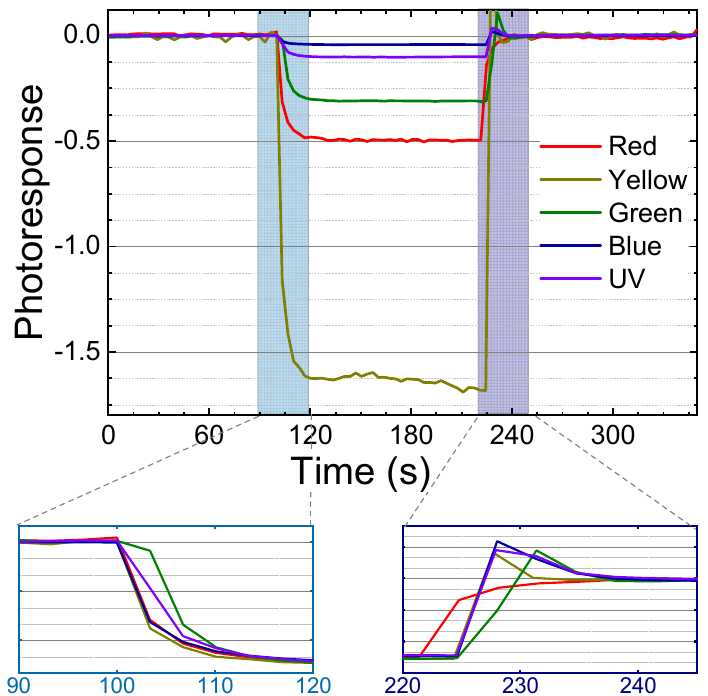
Figure 6. The transient photoconductivity response of Ag/AgO film under illumination by several wavelengths exhibits negative behavior typical of defects presence. The normalization of the plateau in the crosshatched ranges evidences the issues related to response and recovery times depending on the wavelength excitation.